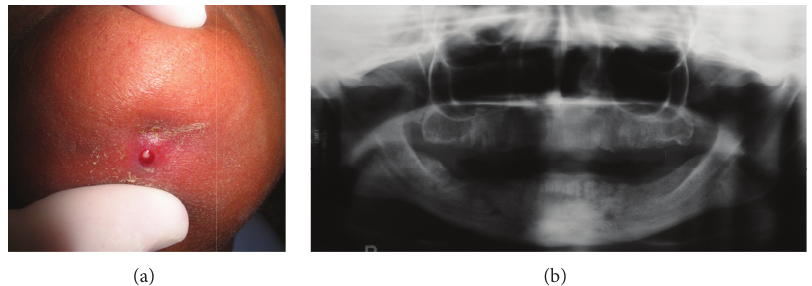
Figure 5: ((a) and (b)) Clinical aspect of BRONJ showing purulent drainage in the submental region and absence of radiographic